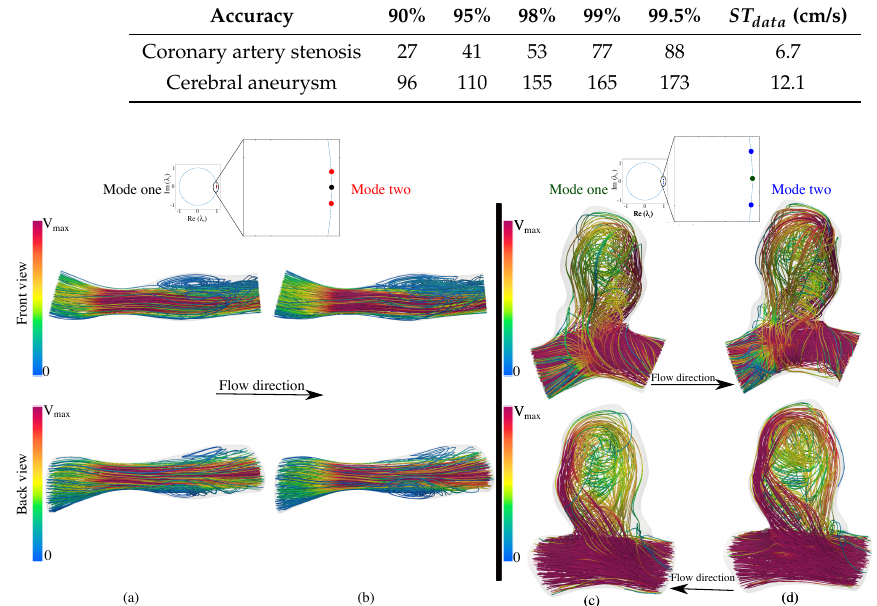
Table 5. The minimum number of modes required to reach a specified reconstruction accuracy in velocity data is shown for the traditional DMD model applied to the entire data. The spatiotemporal average of data ( ST data ) is reported for each system.